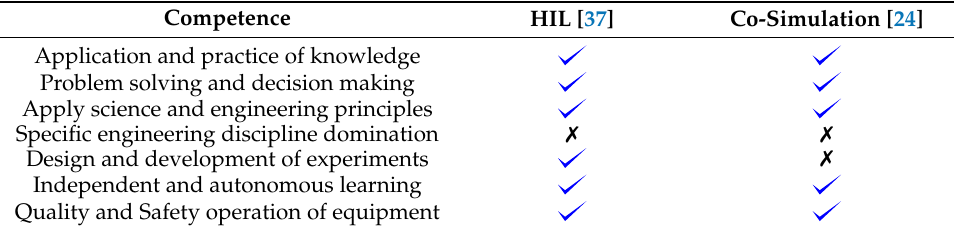
Table 2. Competences endorsement by RT simulation